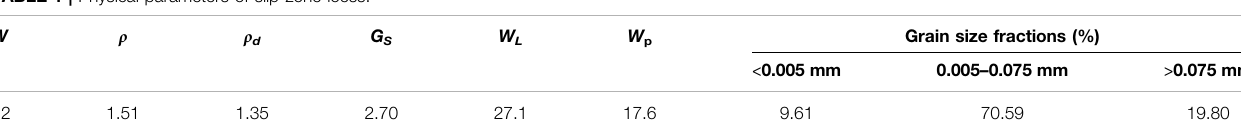
TABLE 1 | Physical parameters of slip-zone